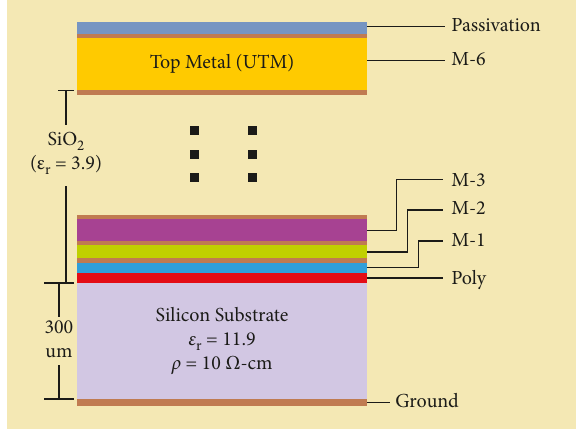
Figure 1: Stacked BEOL metal layers of the TSMC 180nm CMOS process technology.